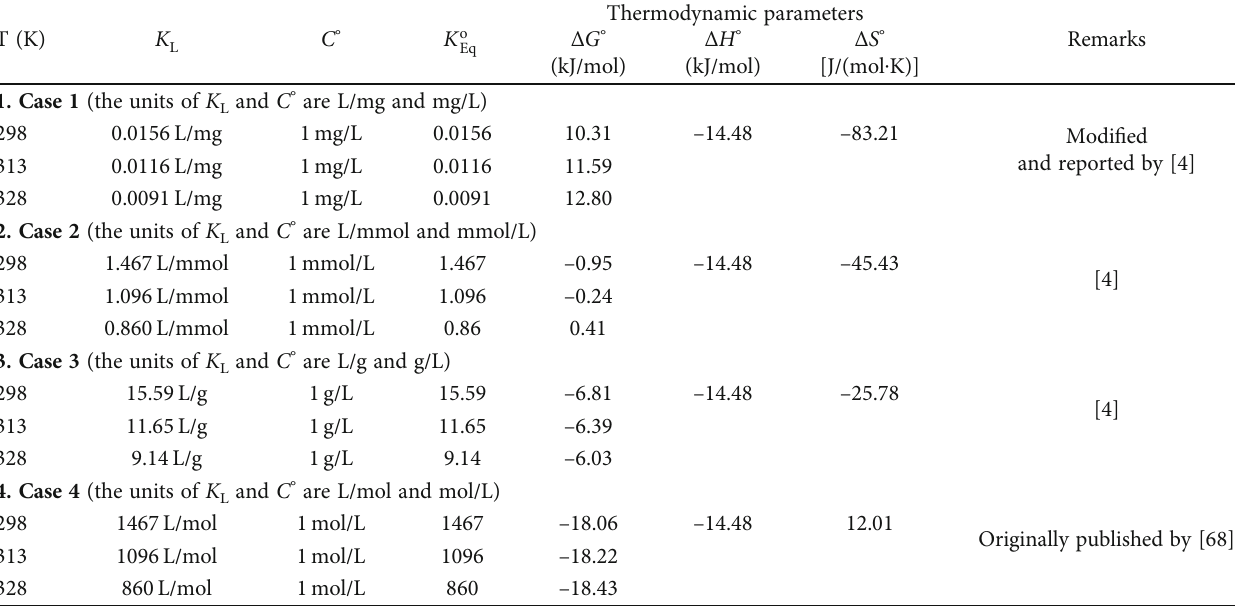
Table 3: Thermodynamic parameters for adsorbing phenol onto bispyridinium dibromides-modi fi ed montmorillonites. T (K) K L